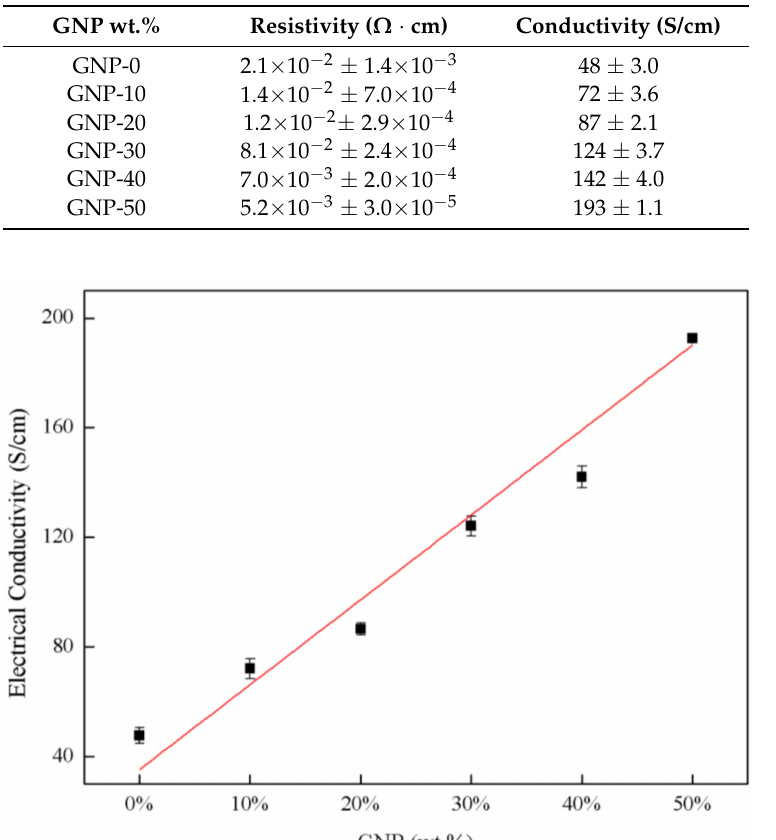
Figure 5. Electrical conductivity of MWCNT/GNP hybrid films with different weight percentages of